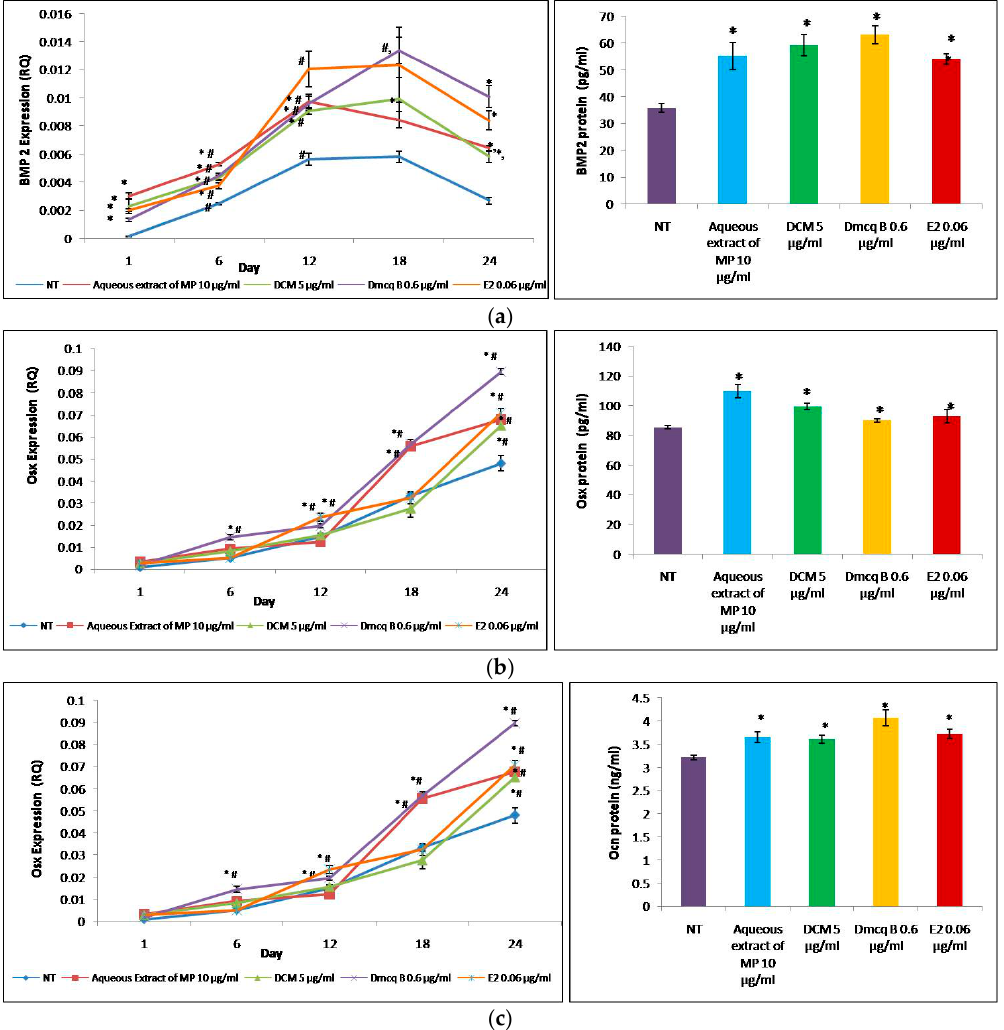
Figure 7. Effects of M. pumilum var. alata crude aqueous extract, DCM fraction, Dmcq B and E2 (positive control) on mRNA expressions of osteoblastic genes during 24 days of differentiation induction and protein expression at the corresponding day of maximal expression of mRNA. ( a ) BMP2 mRNA gradually increased time-dependently up to Day 12, maintained up to Day 18, and decreased to Day 24; ( b ) Osx mRNA gradually increased time dependently and peaked at Day 24; ( c ) Ocn mRNA is produced after Day 6 and peaked to the Day 18 and maintained to the Day 24 in all treatments compared to non-treated group, was peaked up only by the Day 24. Overall, the M. pumilum var. alata treatments showed significant increase in osteoblastogenesis associated genes, which at par with E2 treatment. E2-driven stimulation on gene expression at transcriptomic level was confirmed at protein level. The data are presented as means of percentage of treatment ± SEM; n = 6. * Significantly increased ( p < 0.05) compared to NT group at a corresponding day# significantly increased ( p < 0.05) compared